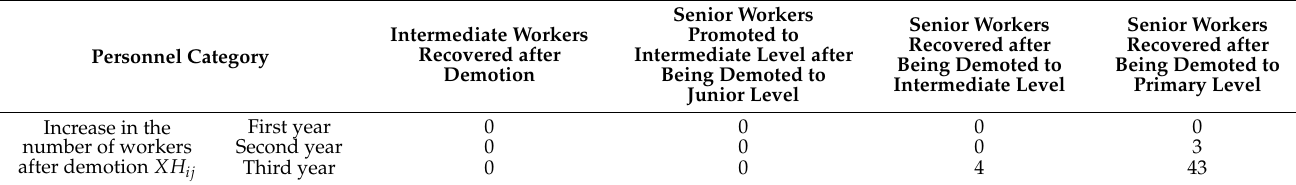
Table 10. Number of workers promoted after demotion in the past three years.